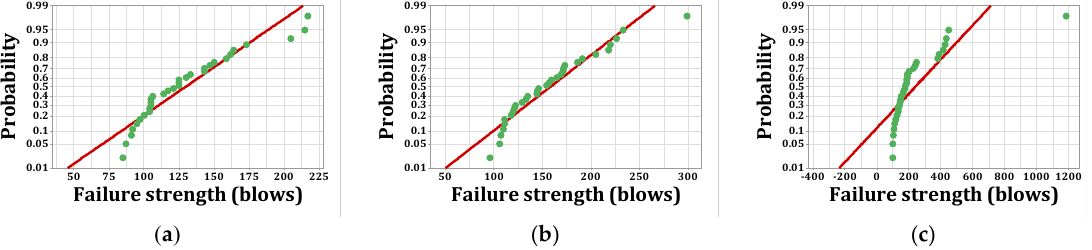
Figure 25. Normal probability plots for failure strength (dry): ( a ) R, ( b ) F2, ( c ) F3.